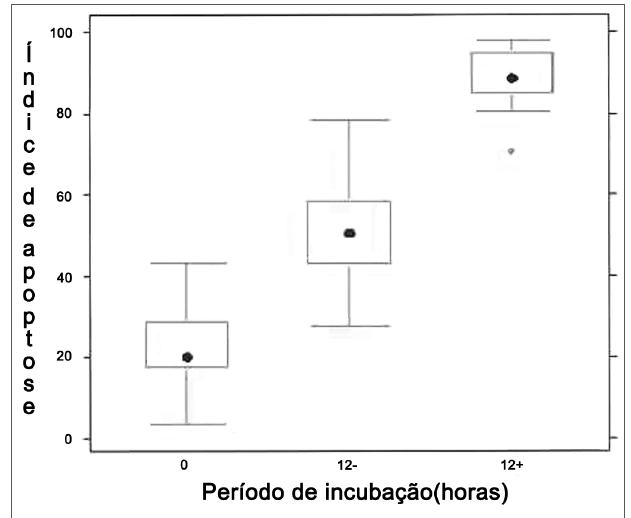
Figura 5. Análise do índice apoptótico por meio de morfometria (coloração hematoxilina-eosina. Ampliação 1000x). Teste de Kruskall Wallis: p < 0,001 para todos os pacientes. Pós-teste de Wilcoxon com correção de Bonferroni: p < 0,001 para todos os pacientes/compara- ções, exceto para ambos marcos zero em que o valor de p = 0,1724. “0” reflete o período de incubação em zero hora; “12-” é a incubação